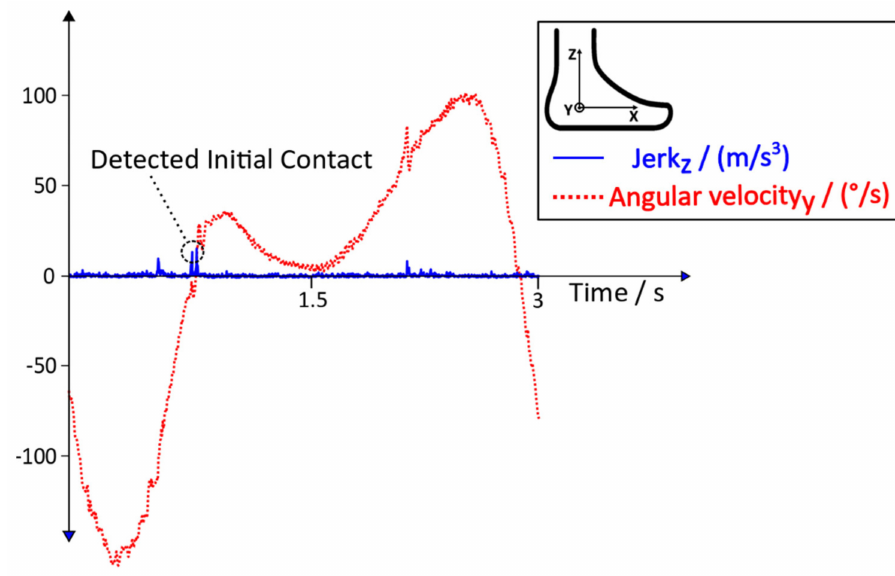
Figure 6. Angular velocity and jerk in the sagittal plane during the robot-assisted gait training of a healthy person, adapted from